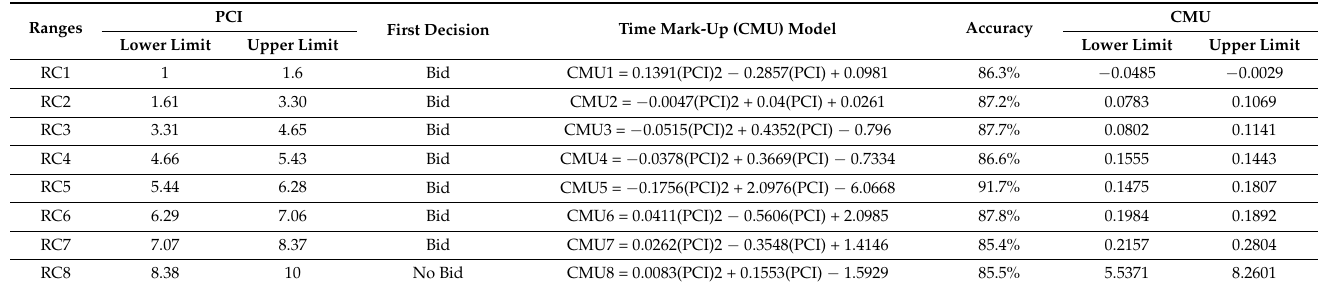
Table 8. Relation between the PCI and TMU based on data from 111 projects. Table 7. Relation between the PCI and CMU based on data from 111 projects.